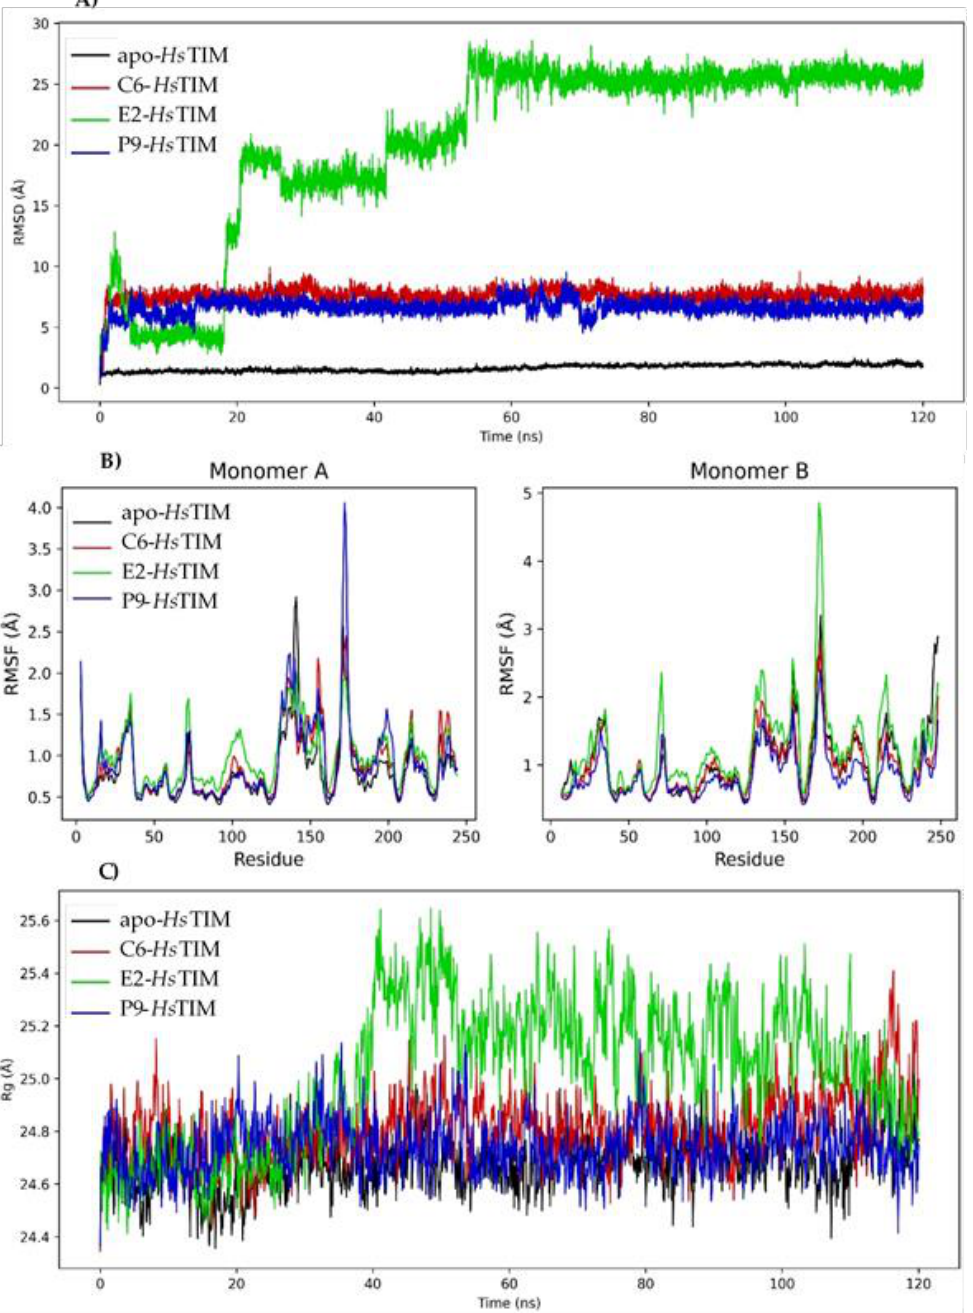
Figure 4. Molecular dynamics simulation of benzimidazole derivatives in complex with Hs TIM. ( A ) Plot of RMSD of the three complexes and apo- Hs TIM. ( B ) Diagram of the RMSF of the three complexes and apo- Hs TIM. ( C ) Diagram of the Rg of the three complexes and apo- Hs TIM.